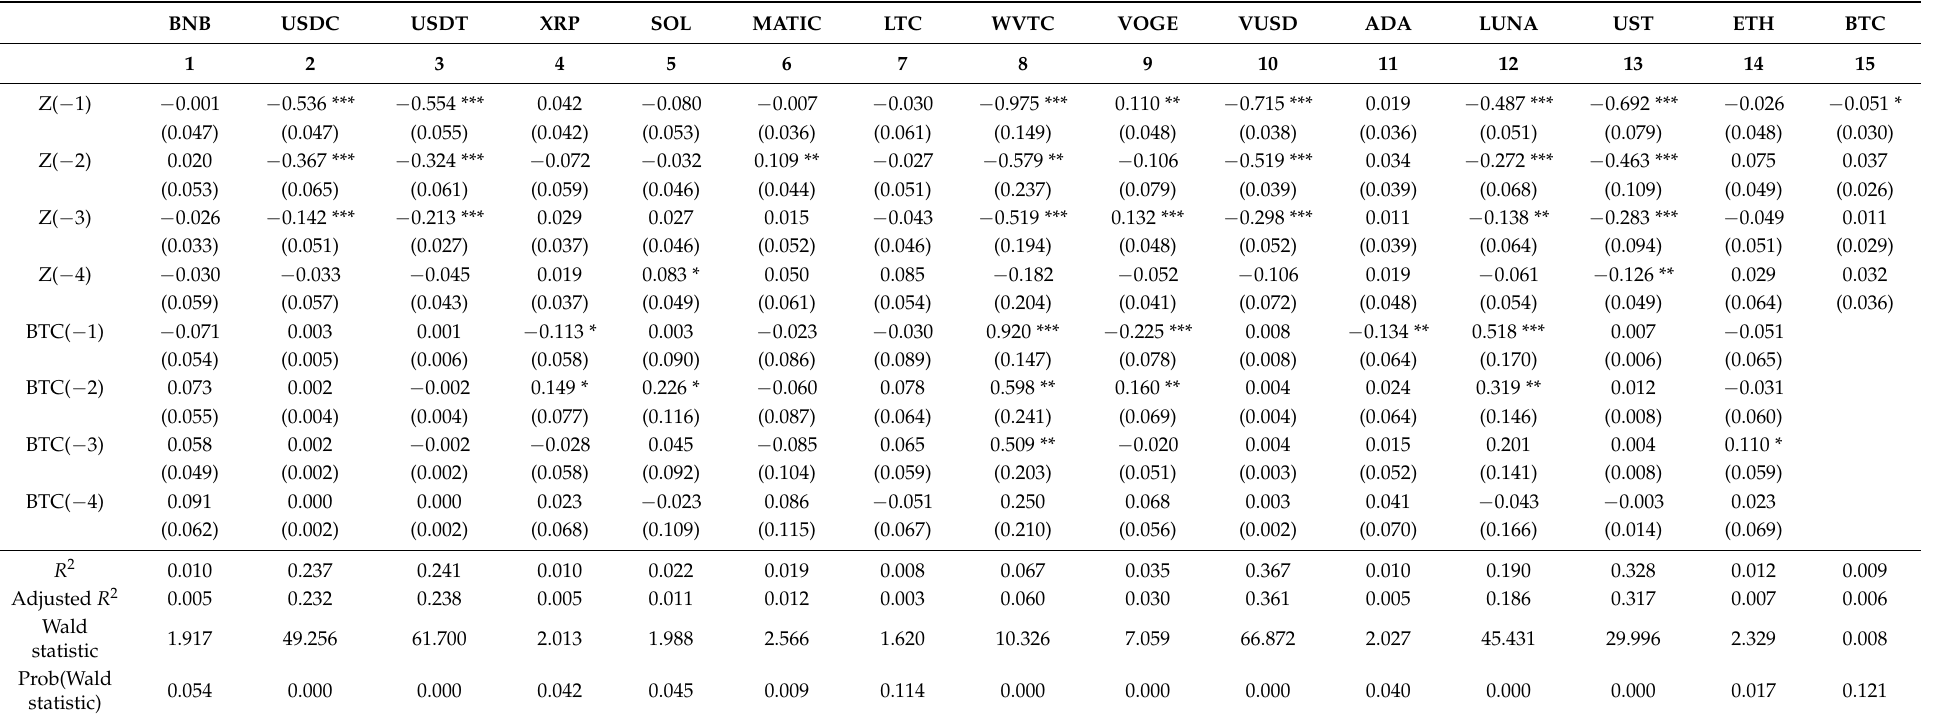
Table 1. The in-sample results for one-step-ahead